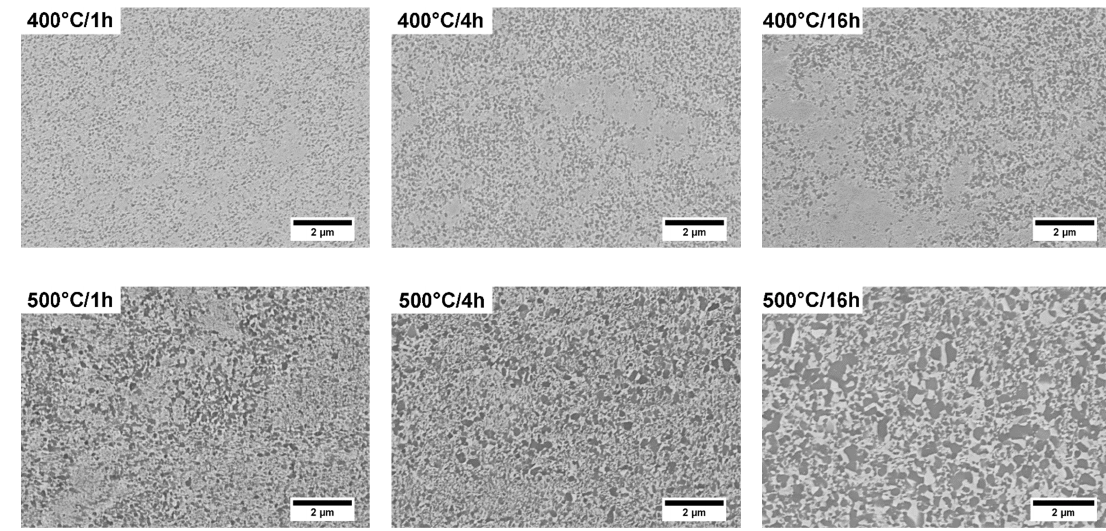
Figure 5. SEM–BSE micrographs of the samples deformed by high-pressure torsion (HPT-deformed samples) after ageing.